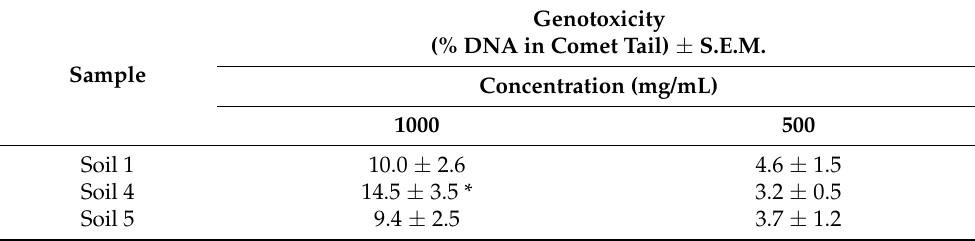
Table 5. Genotoxicity of the soil extracts sampled from the landfill to A-549 lung epithelial cells as % of DNA in the comet tail in the alkaline comet assay. Results presented as the mean of the 50 cells analysed for each concentration ± S.E.M. * Results significantly different from unexposed control ( p < 0.05).